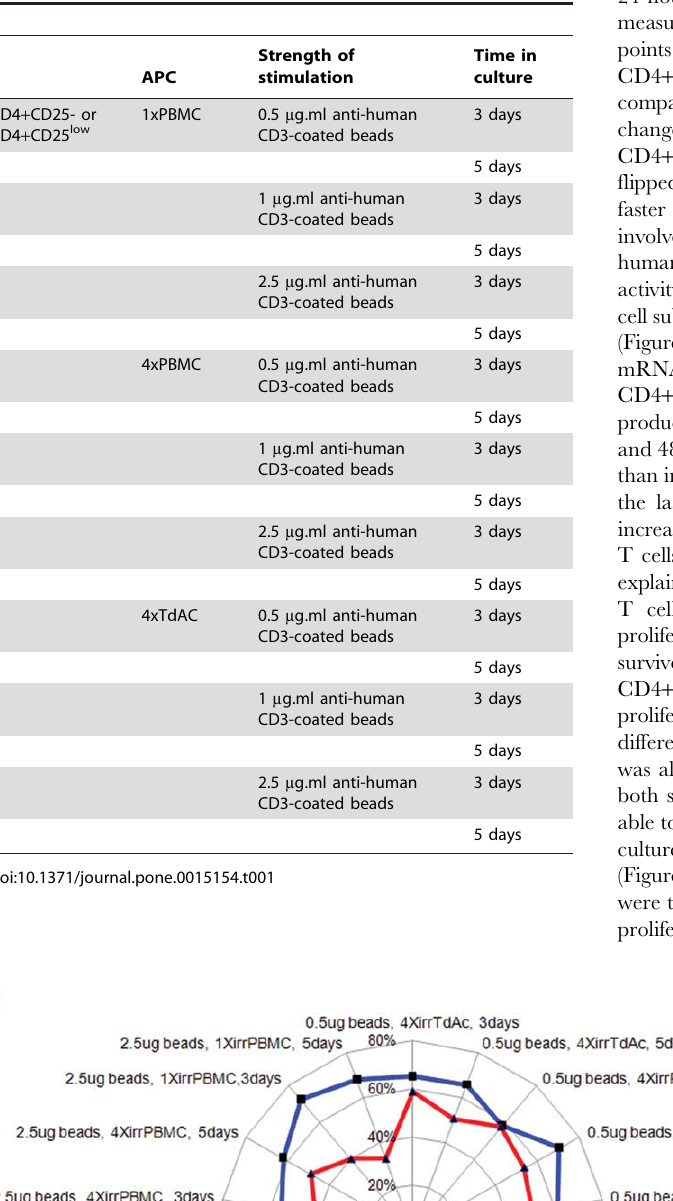
Table 1. Tested variables in in vitro human suppression